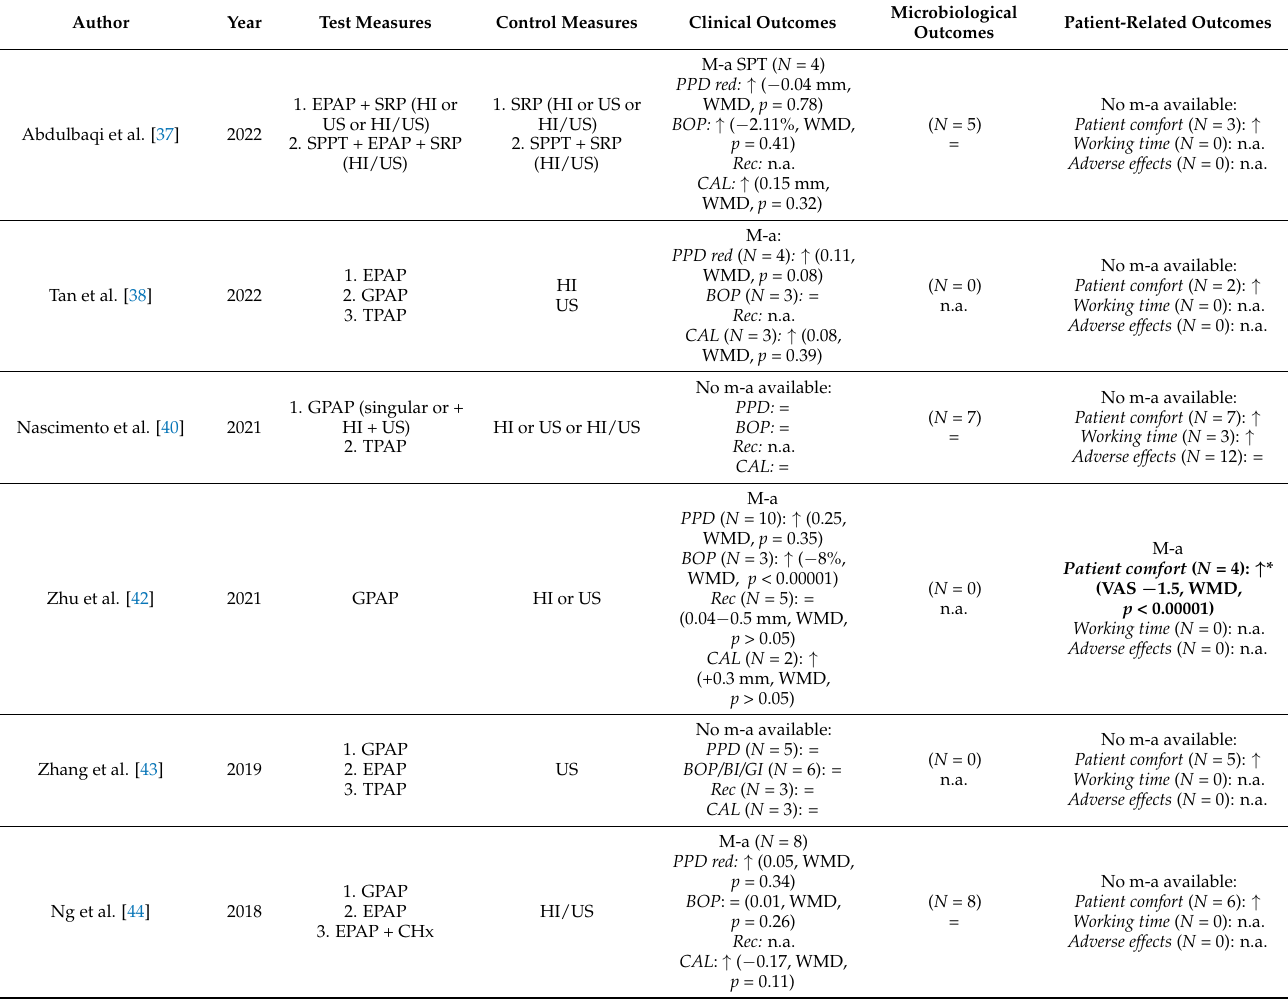
Table 3. Results of the included systematic reviews on supportive periodontal therapy. (BOP: bleeding on probing reduction; CAL: clinical attachment level gain; CHx: Chlorhexidine; EPAP: erythritol powder air polishing; GI: gingival index; GPAP: glycine powder air polishing; HI: hand instruments; M-a: meta-analysis; N: number of included studies; n.a.: not available; PPD red: periodontal pocket depth reduction; TPAP: trehalose powder air polishing; Rec: gingival recession; SPPT: simplified papilla preservation technique; SRP: scaling & root planing; US: ultrasonic scaler; VAS: visual analogue scale; WMD: weighted mean difference; =: no difference; ↑ : (*significant) better results in the test group; ↓ : (*significant) worse results in the test